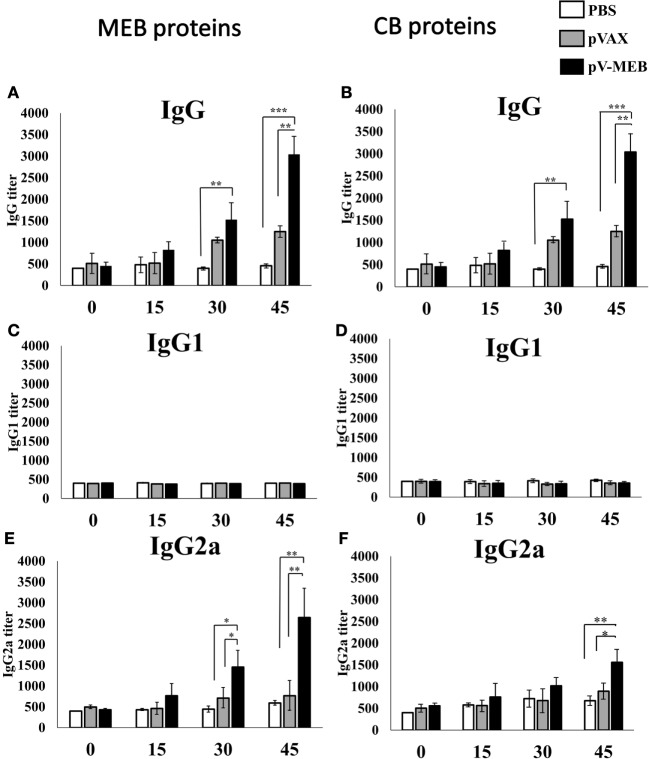
Titers of specific IgG (A,B), IgG1 (C,D), and immunoglobulin G2a (E,F) production after immunization with recombinant pV-MEB vaccine. Sera obtained from each group of mice were used for detection of antibodies against purified rMEB proteins (A,C,D) and crude Brucella proteins (B,D,F) by indirect enzyme-linked immunosorbent assay. Sera obtained at days 0, 15, 30, and 45 post-immunization were serially diluted in phosphate buffer saline and used in the assay (*P < 0.05, **P < 0.01, and ***P < 0.001).